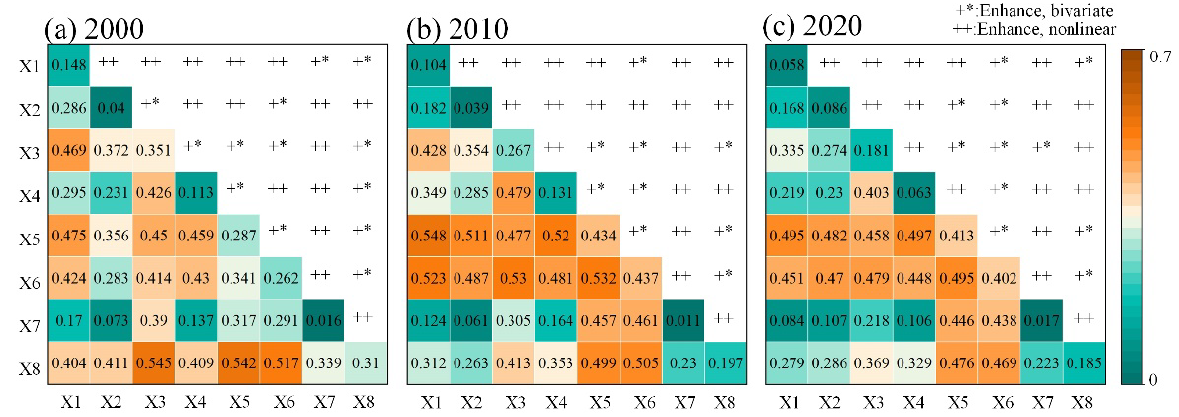
Figure 9. Results of the interaction detection, ( a ) 2000, ( b ) 2010, ( c ) 2020.